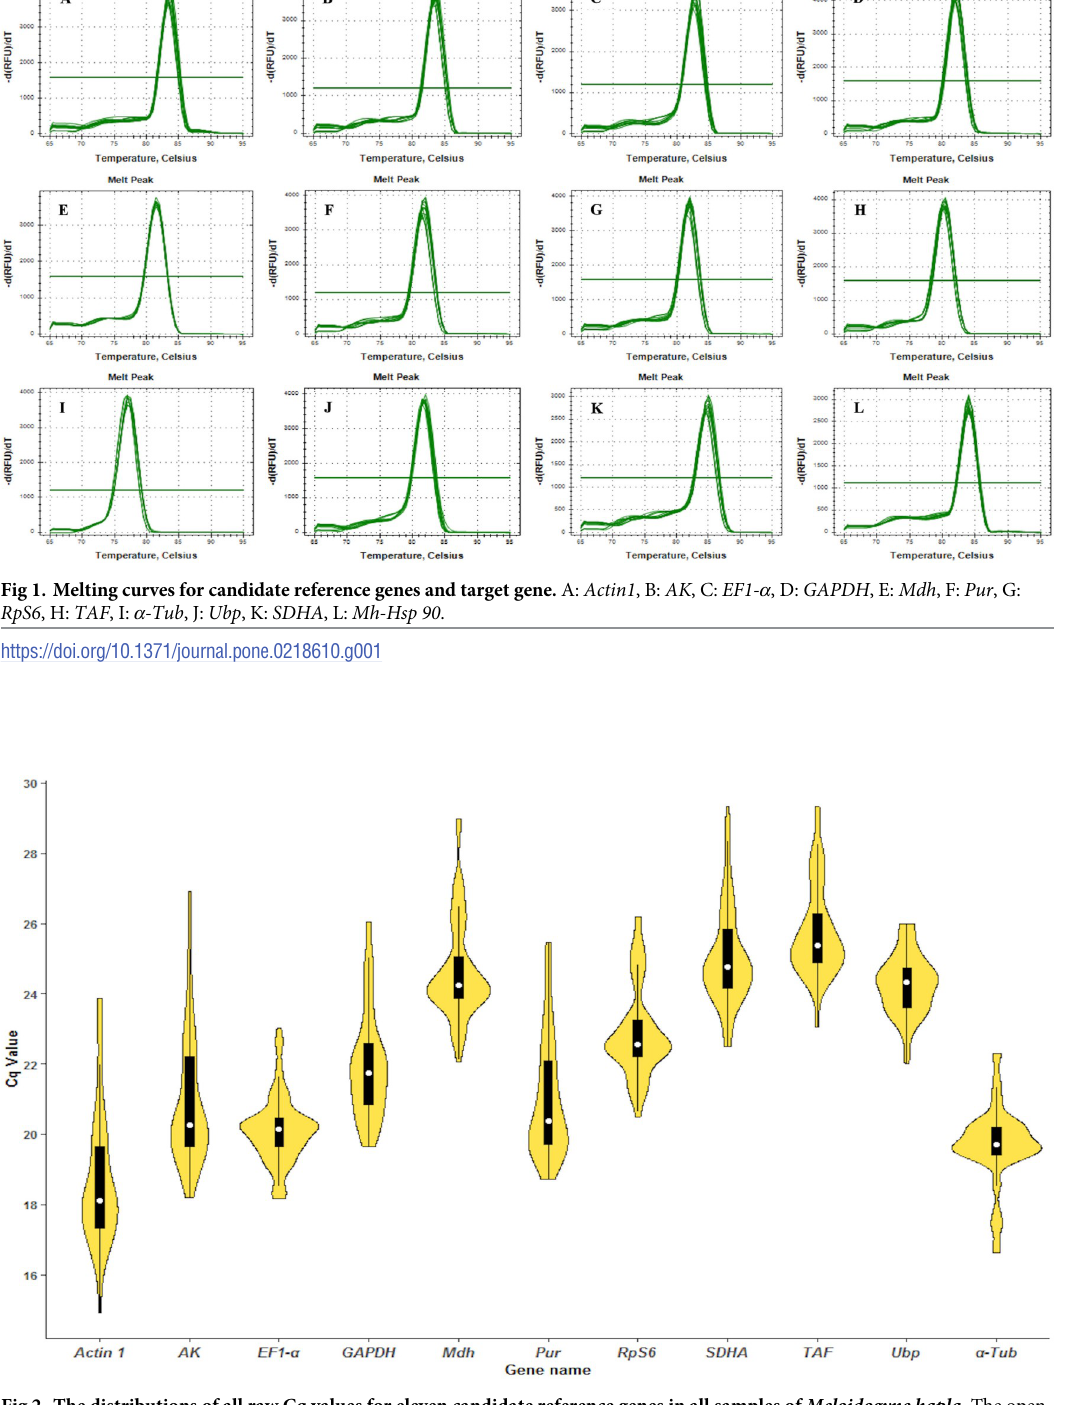
Fig 2. The distributions of all raw Cq values for eleven candidate reference genes in all samples of Meloidogyne hapla . The open circle inside the boxes represents the median. The black bold lines present the 25 th and 75 th percentiles. The thin lines indicate the 5 th and 95 th